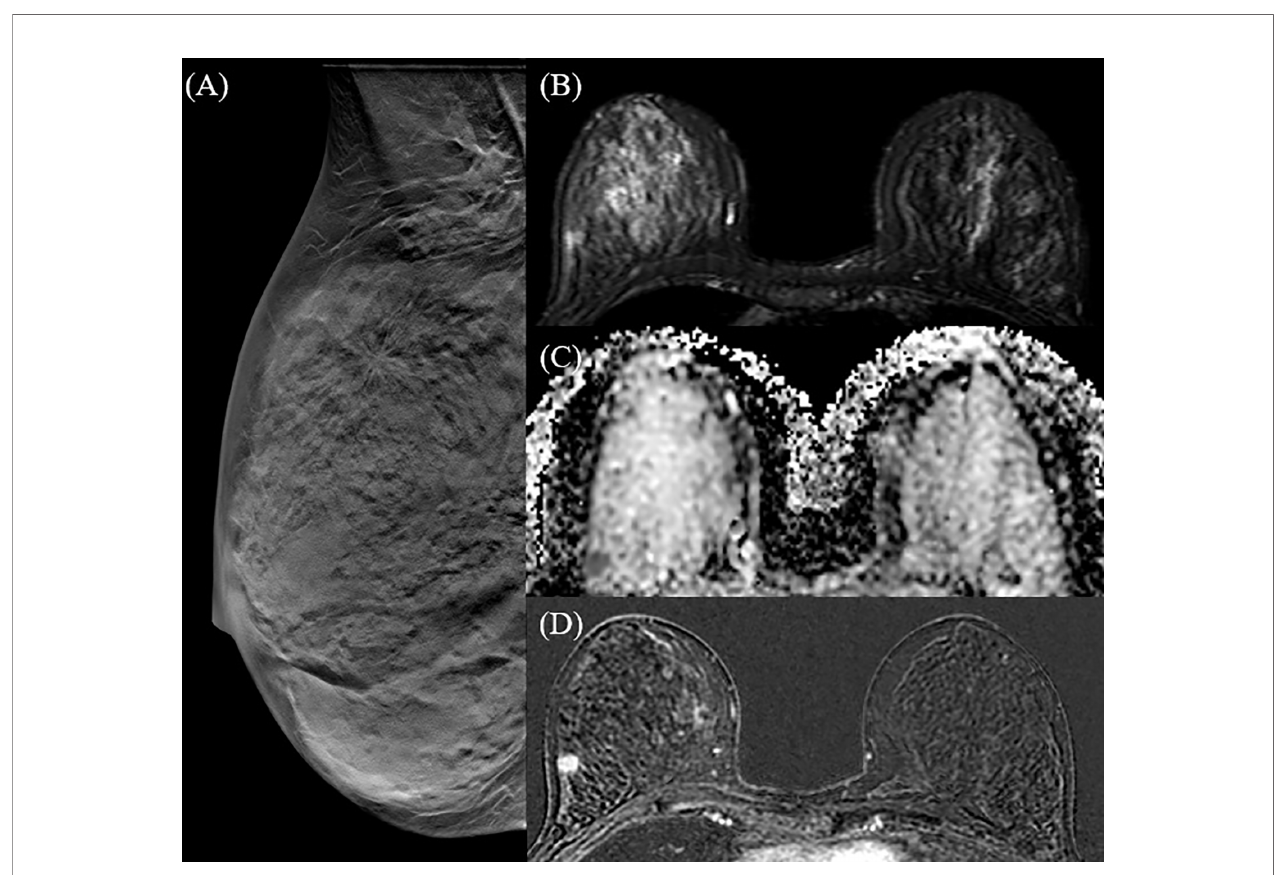
FIGURE 2 | 42 y-o woman with unifocal invasive ductal carcinoma (IDC). Right breast DBT MLO projection (A) identi fi es a single spiculated opacity in the upper- outer quadrant, corresponding to the hyperintense area in the T2 fat-saturated sequence (B) and to the hypointense area in the ADC map (C) . T1 fat-saturated post- contrast post-processing subtraction image (D) con fi rms a mass enhancement in the right breast, with high morphological and dimensional